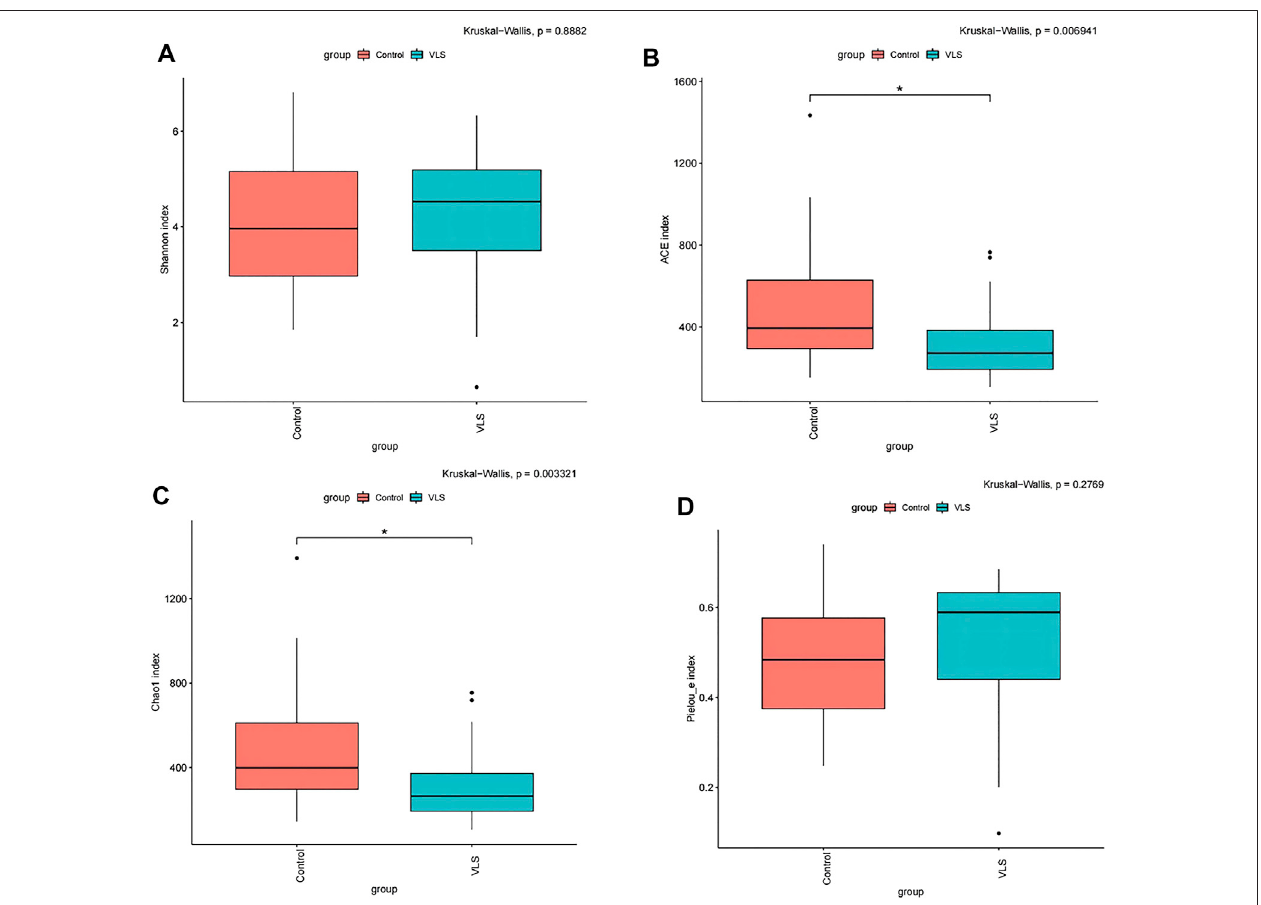
FIGURE2|(A) Shannondiversity index( α -diversity)ofthevulvarmicrobiota betweentheVLSandcontrolgroups.ACE index (B) andChao1index (C) (richness)of vulvarmicrobiotabetweentheVLSandcontrolgroups. (D) Pielouindex (D) (evenness)ofvulvarmicrobiotabetweentheVLSandcontrolgroups.* p valueslessthan0.05 were considered statistically signi fi